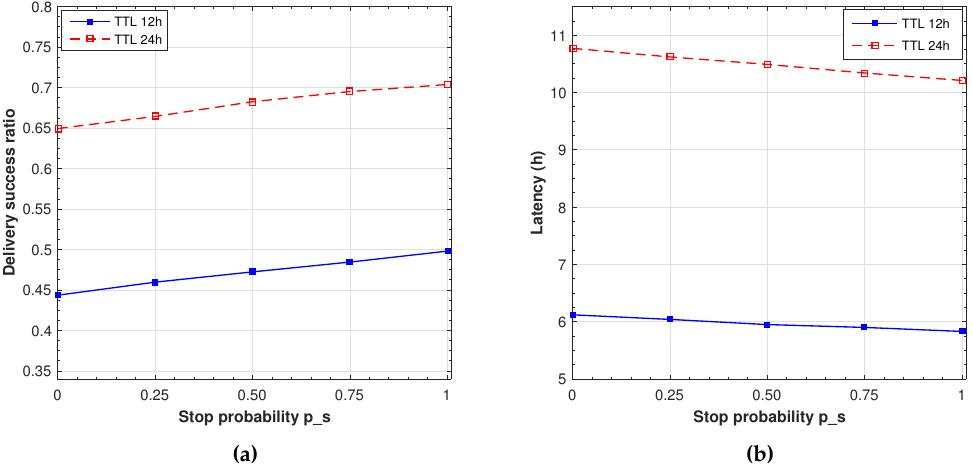
Figure 11. Delivery ratio ( a ) and latency ( b ) for different contact stop probabilities (16 s max.